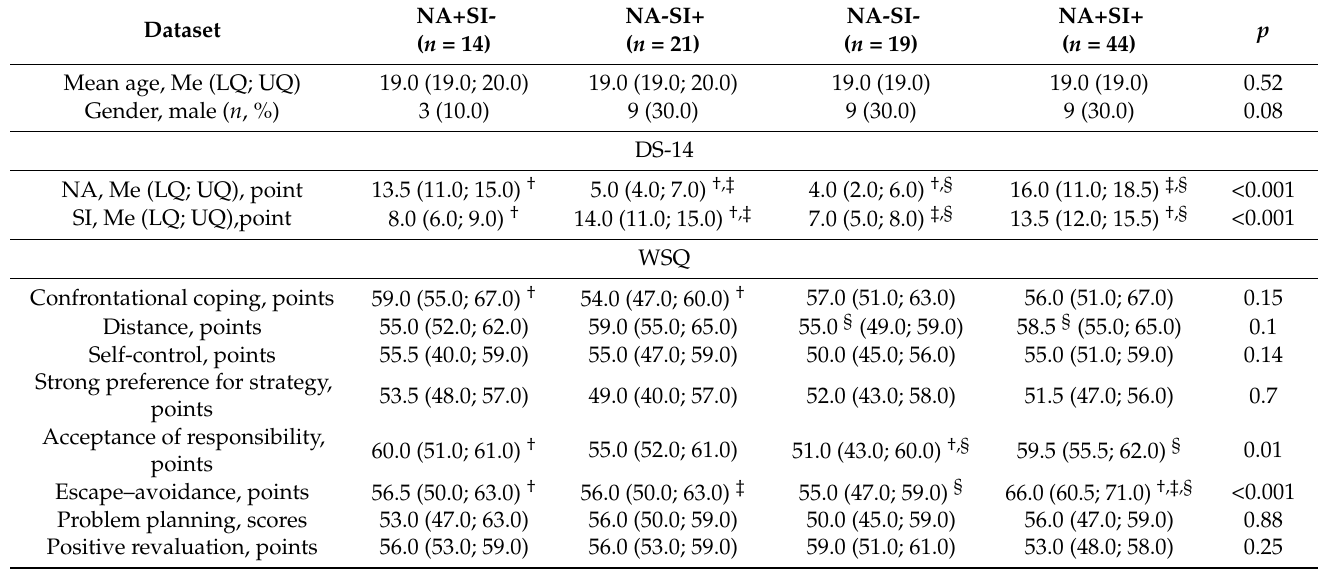
Table 1. Variables at baseline according to type distress personality DS-14,